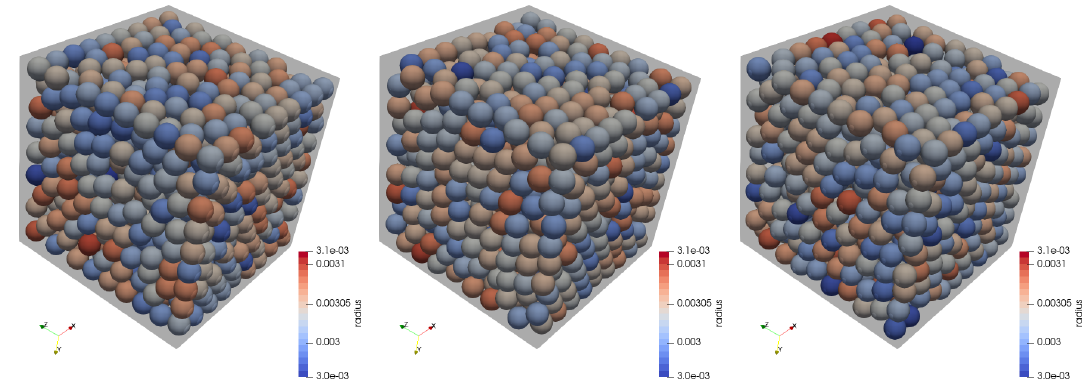
Figure 7. Virtual bed samples numbered 1, 2, and 3 (counting from the left).